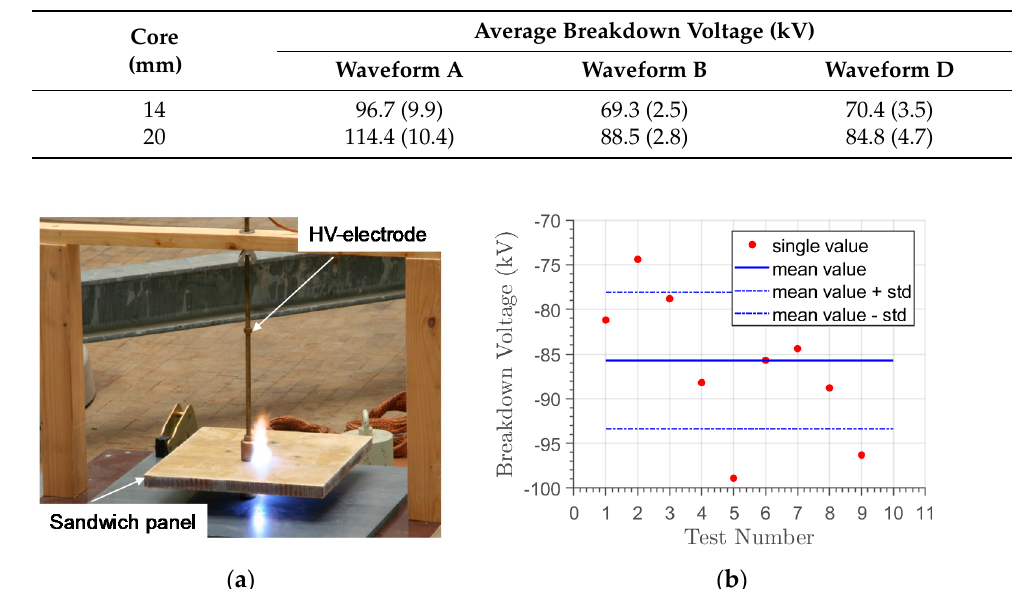
Table 1. Average breakdown voltage for the 2 types of sandwich panels. The standard deviations are given in brackets.